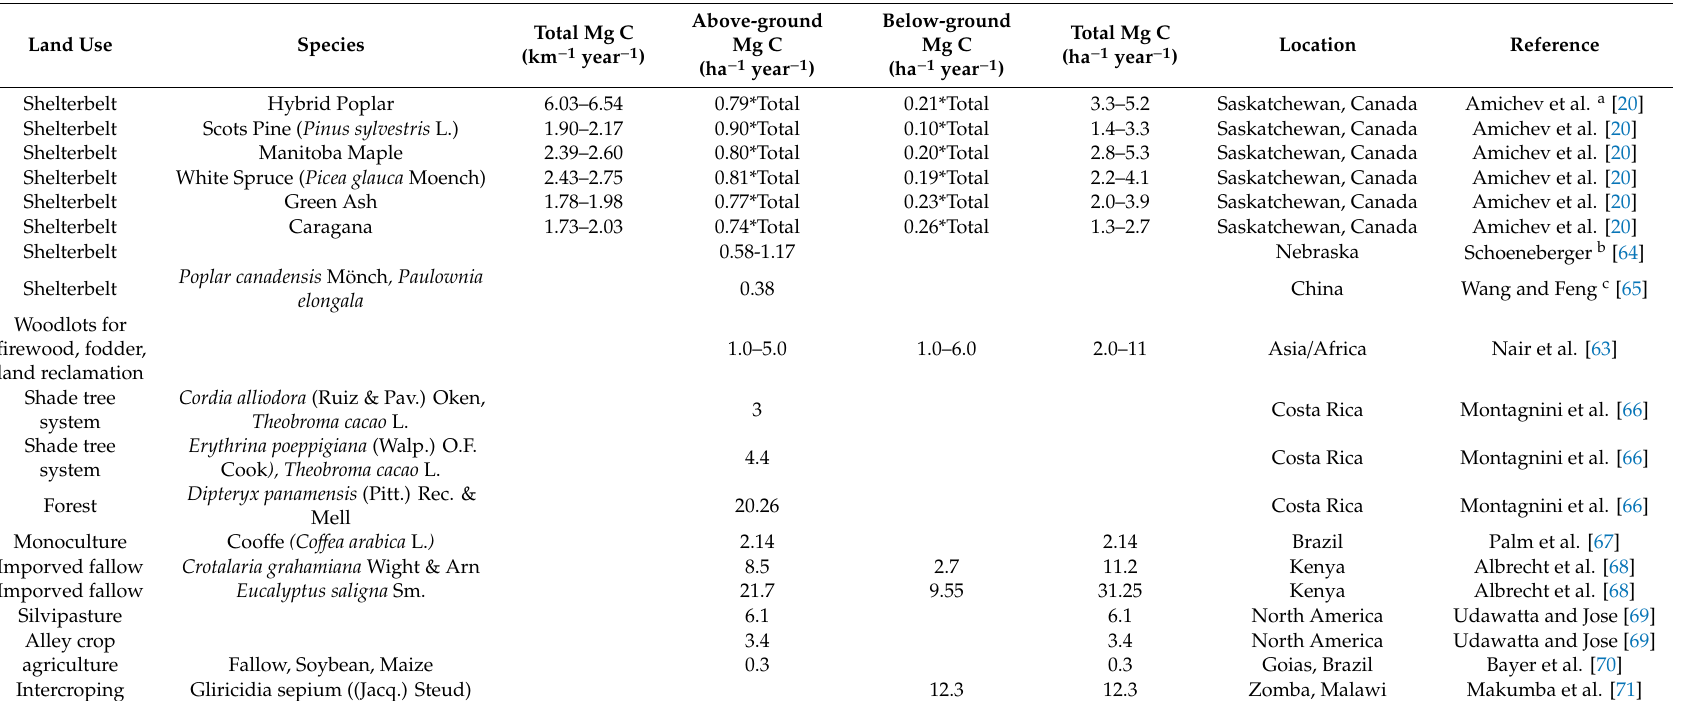
Table 2. Carbon sequestration potential of diverse land use classes using di ff erent tree species around the